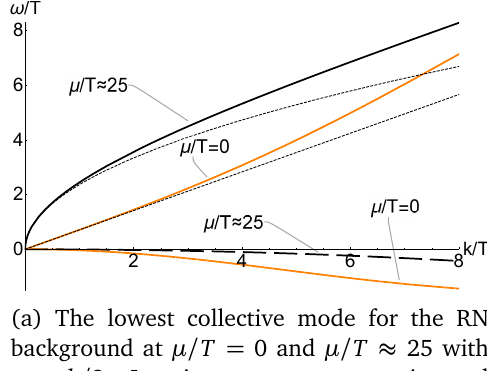
(b) The lowest collective mode for the RN (a) The lowest collective mode for the RN background at µ/ T = 0 and µ/ T ≈ 25 with background at µ/ T = 0 and µ/ T ≈ 25 with p = k / 2. Imaginary parts are negative and p = k / 2. Imaginary parts are negative and dashed. The thin dotted black line (mostly in- dashed. The thin dotted black lines are the (cid:112) side the orange line) is the expected k → ∞ 2 and expected k → 0 asymptotes ω = k / (cid:112) ω ∝ asymptote ω = k k respectively.